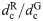
Summary of response measures from area-response curves with triadic inhibition present.(A) Ratio of receptive-field center diameter of relay cell (RC) and (central) retinal ganglion cell (GC), dcR/dcG; receptive-field center diameter measured as the spot diameter corresponding to the largest firing rate in the area-summation curves in Fig 9. (B) Ratio of receptive-field center diameter of interneuron (IN) and relay cell (RC), dcI/dcR. (C) Relay-cell αR (solid) and interneuron αI (dashed) center-surround antagonisms, cf. Eq 7. (D) Maximal firing rate rc, i.e., firing rate for spot exactly covering receptive-field center, for relay cell (rcR, solid) and interneuron (rcI, dashed). The colored lines correspond to different values of wGIp, see legend below panels. Note also that interneuron (IN) results are absent for the case with wGIp = 0 (blue lines) since in this case the IN only receives triadic input and does not fire any action potentials.